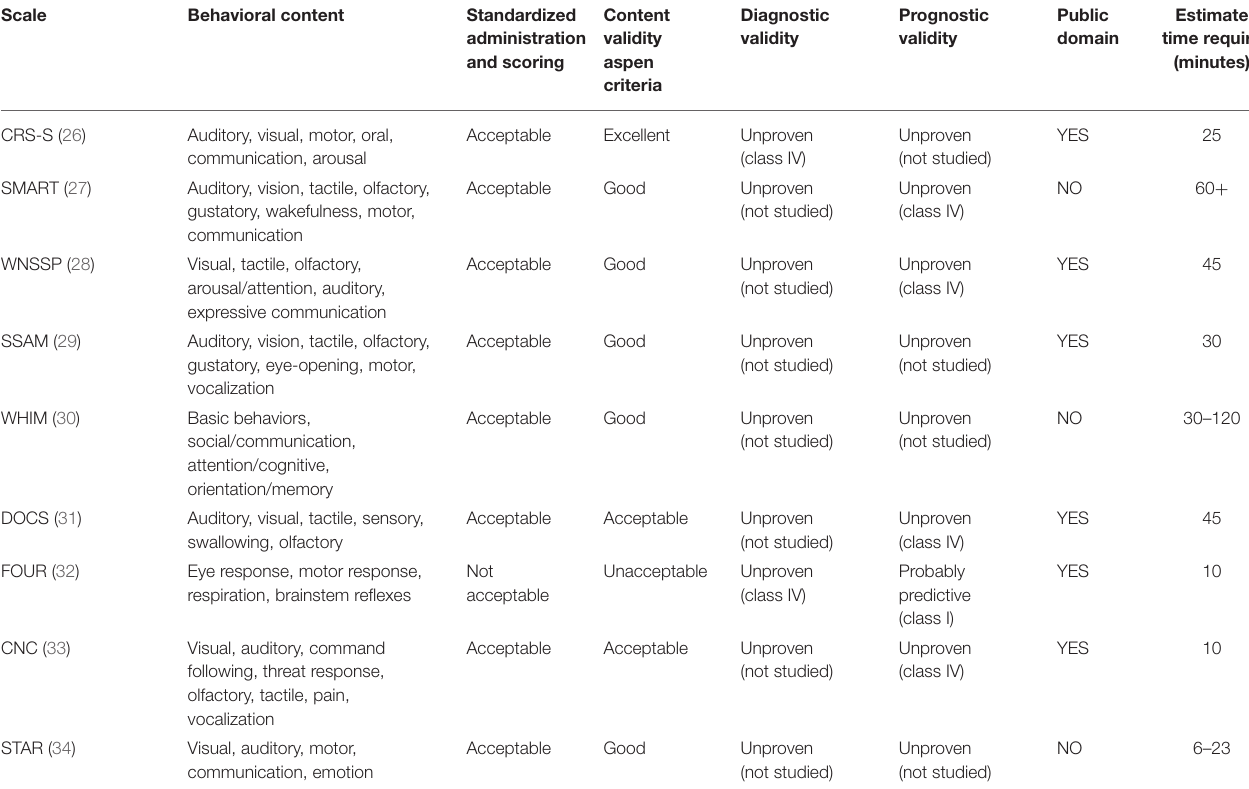
TABLE 1 | Assessment scales